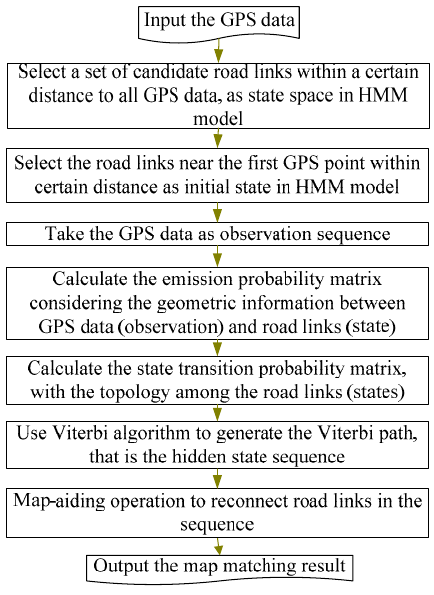
Figure 5. Processes in HMM-based map-matching.